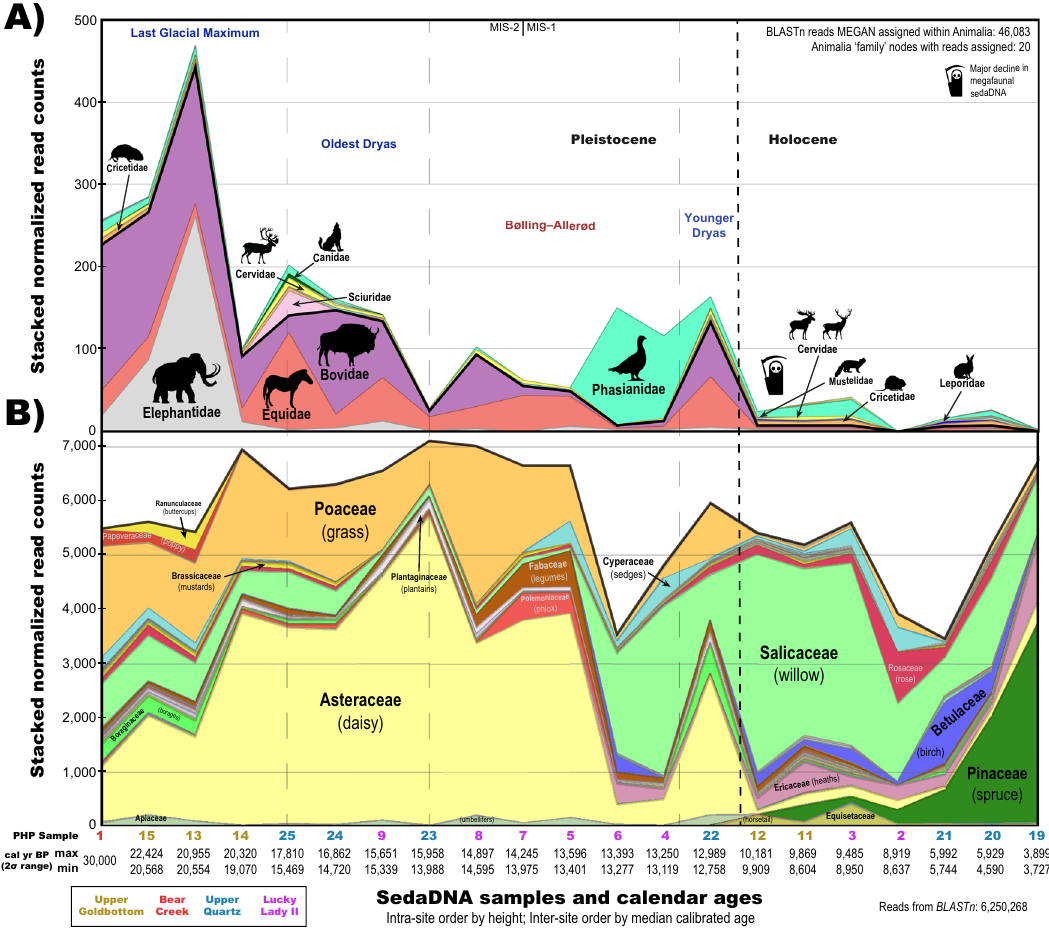
Fig. 3 Major taxonomic shifts in relative sedaDNA read assignment through time. Stacked normalized reads assigned to the rank ‘ family ’ in ( A ) Animalia (insects excluded) and ( B ) Viridiplantae. See Supplemental Figs. 10 – 12 for a metagenomic breakdown of samples by site. Source data are provided as a Source Data fi le. Note: sedaDNA abundance is likely affected by variable taphonomic intensity through time (such as temperature, moisture, and acidity) among other known and unknown micro-environmental conditions and recovery biases. While eDNA abundance and biomass arguably retain some correlation upon initial release, many other factors in fl uence this relationship. As such, relative abundances with sedaDNA must be interpreted cautiously pending further